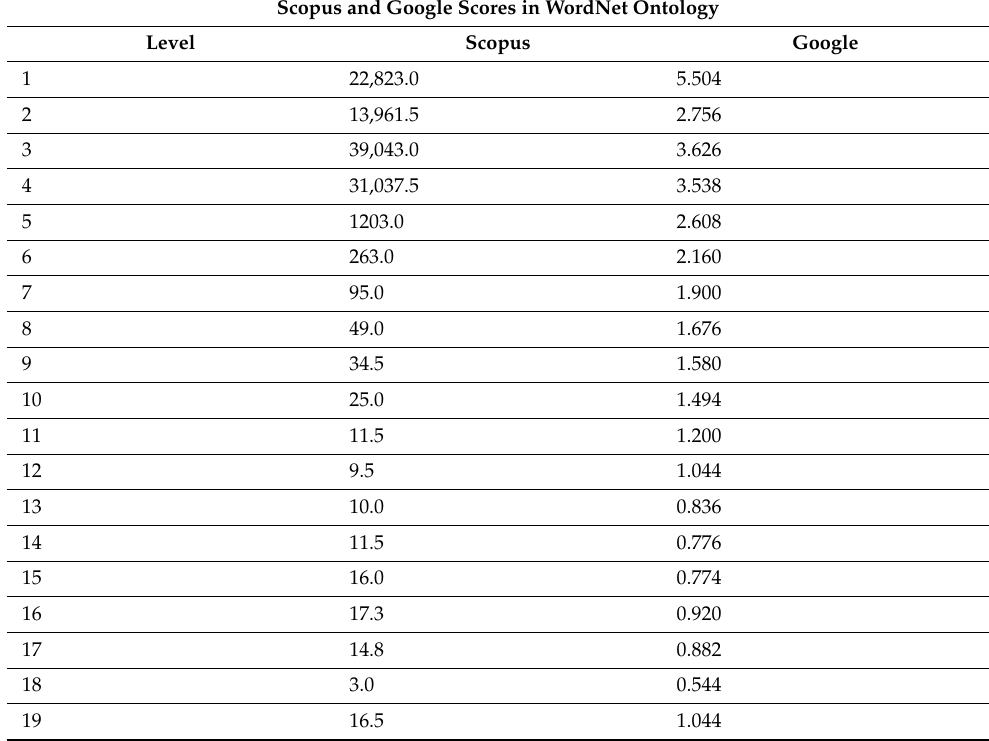
Table 1. Scopus and Google scores per depth level in WordNet. All values are the average scores of each synset with the same distance to the root node, and the value of each synset was computed by considering the median value of all lemmas within the synset. Note that level 1 only has the root synset. Scopus and Google Scores in WordNet Ontology Level Scopus Google 22,823.0 5.504